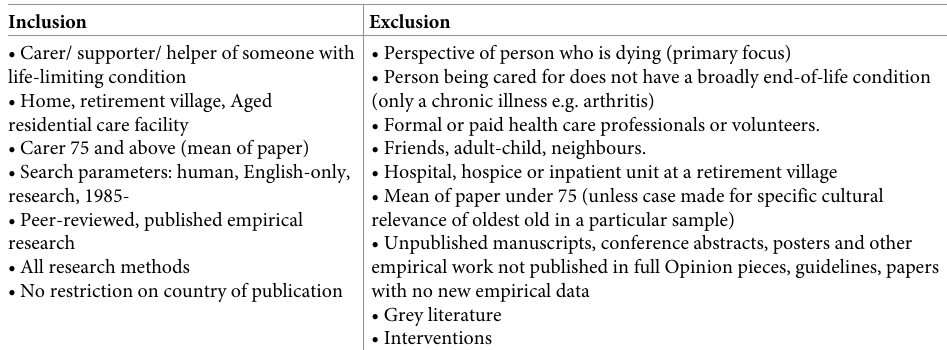
Table 1. Inclusion and exclusion